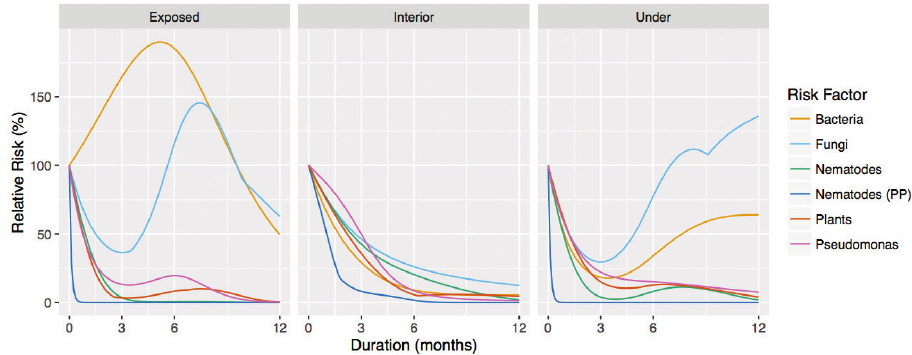
Figure 8. Changes in relative amounts of biota against duration, by storage location. Where the relative amount differed by soil origin, the maximum was chosen. In the legend, ‘Nematodes (PP)’ represents plant parasitic